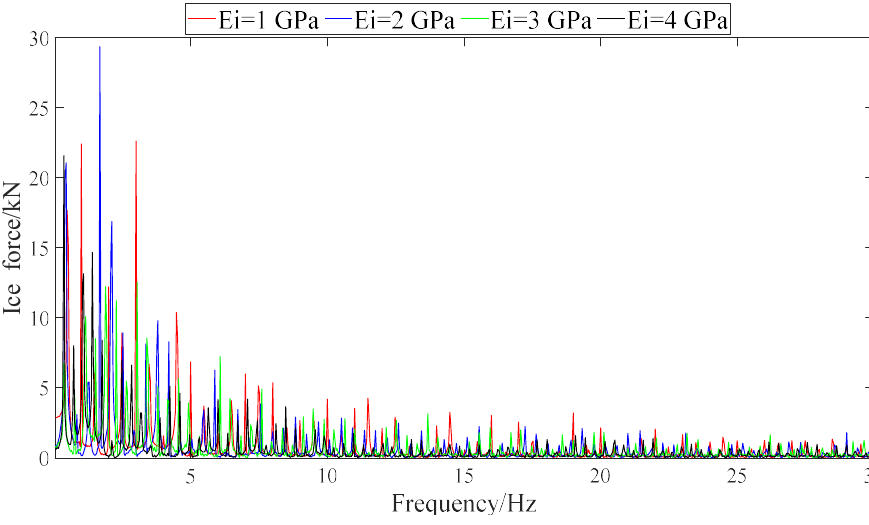
Figure 30. Change trend of variance and ice force with Young’s modulus ( E i ).